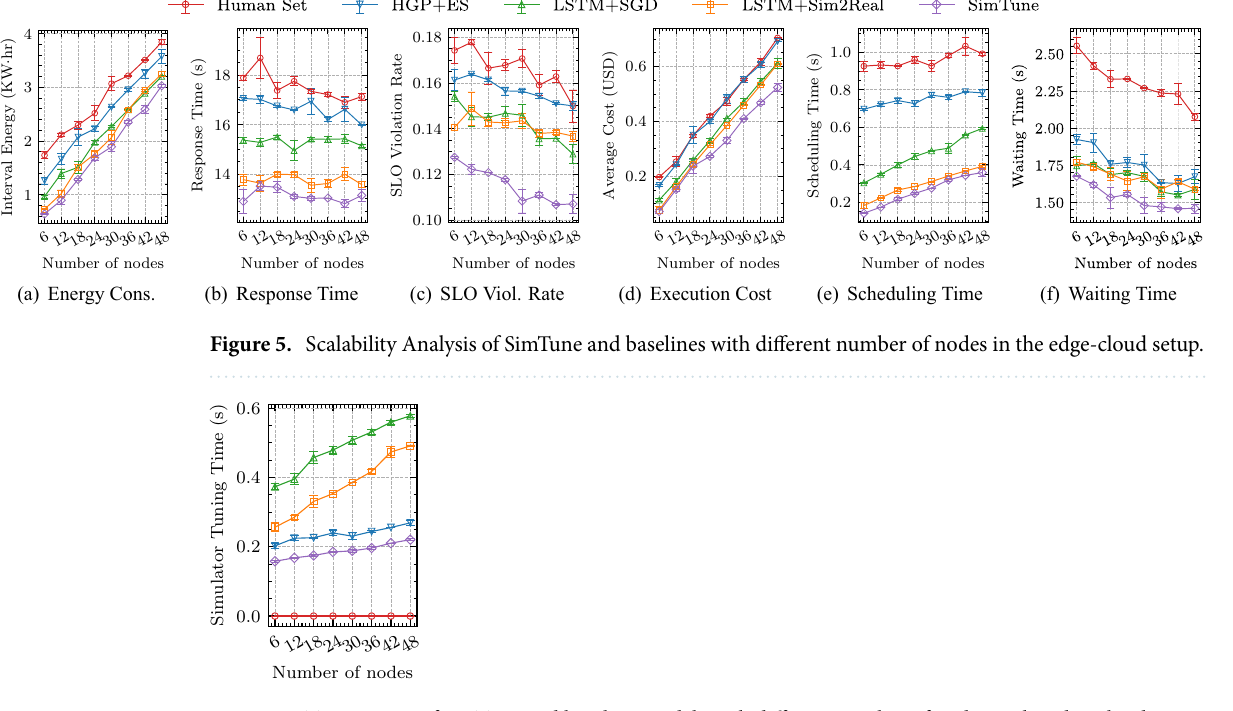
Figure 6. Tuning time of SimTune and baseline models with different number of nodes in the edge-cloud